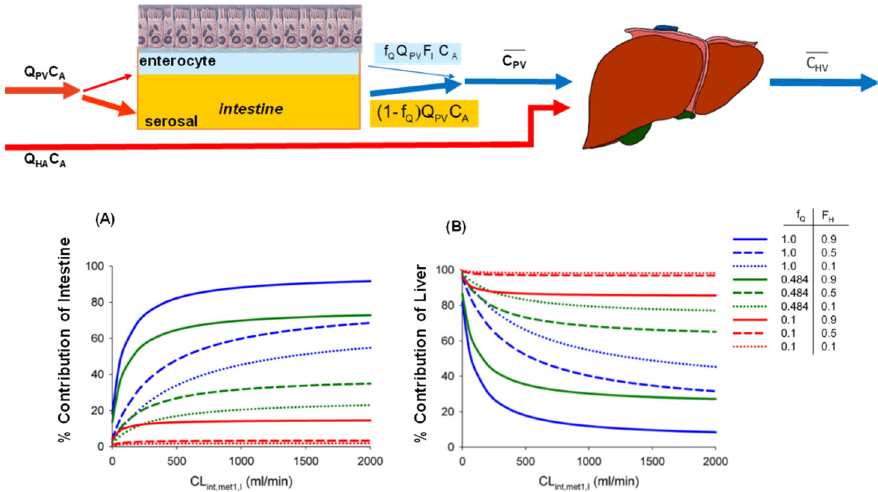
Figure 4. Drug removal by the intestine–liver unit: the intestine controls the substrate flux to the liver. The contributions of intestinal ( A ) and liver ( B ) removal are given by Equations (3) and (4). The drug in the circulation enters two subcompartments of the intestine—the enterocyte and serosal compartments. Removal by the enterocyte but not seroal compartment results in a flow-averaged portal venous concentration,C PV . If intestinal removal is high, the contribution by the liver is opposite and will be low. This figure was modified with permission from Pang and Chow [49], ASPET, 2012.